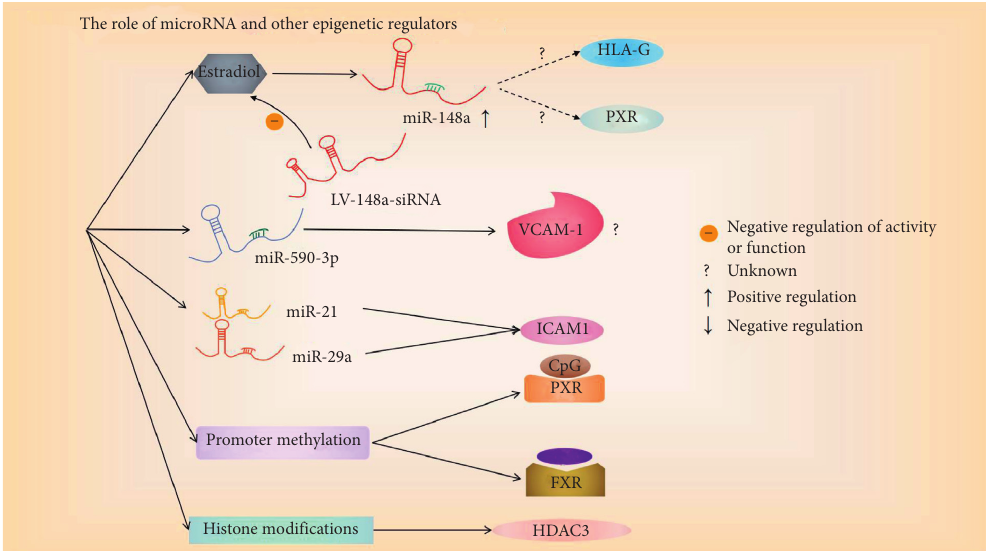
Figure 1: The role of genetic regulatory factors in the pathogenesis of ICP. Estradiol (inhibited by LV-148a-siRNA) can upregulate miR- 148a, and its potential targets are HLA-G and PXR; miR-590-3p can regulate the expression of VCAM-1; miR-21 and miR-29a can inhibit ICAM1. In addition, the CpG sites of FXR and PXR promoters are less methylated in ICP patients. For histone modification, the expression of HDAC3 in ICP is low. The question mark indicates that it has not been confirmed, the dotted line indicates the potential target, and the specific regulation path is shown in the arrow in the figure.